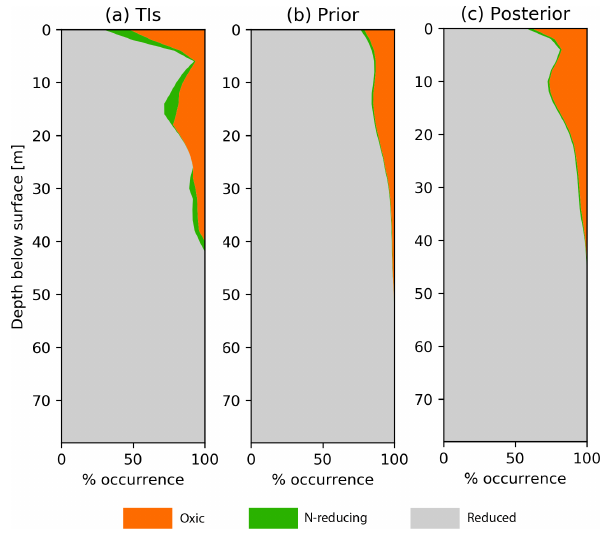
Figure 12. Accumulative probability profiles of redox conditions in the study area for (a) TIs, (b) prior distribution and (c) posterior